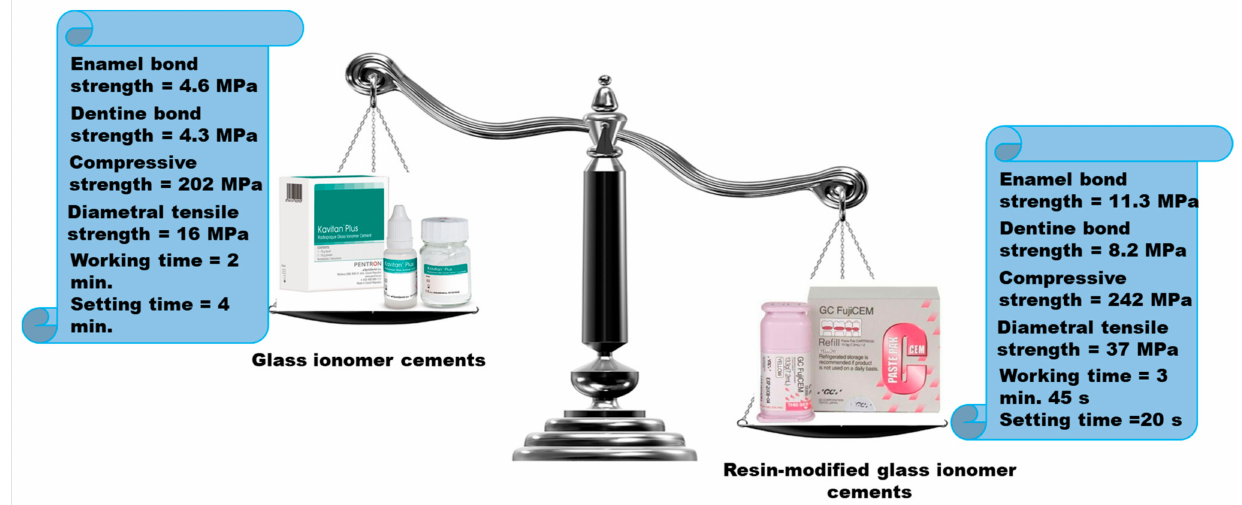
Figure 6. Properties of resin-modified glass ionomers compared with glass ionomers.